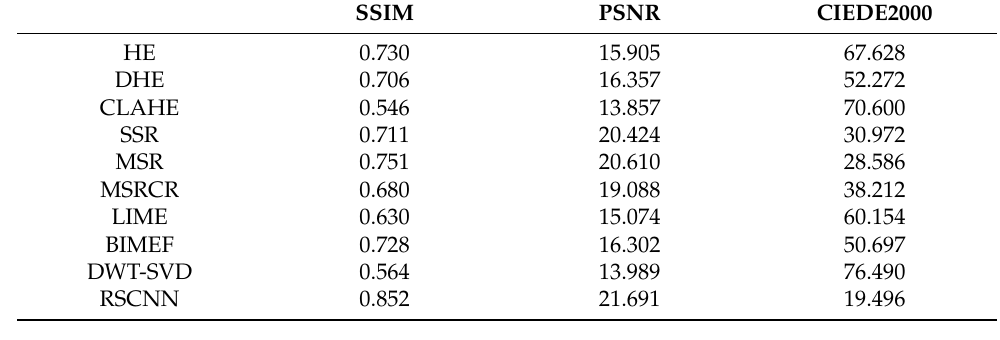
Table 3. Average SSIMs and PSNRs of the test results after fine-tuning.